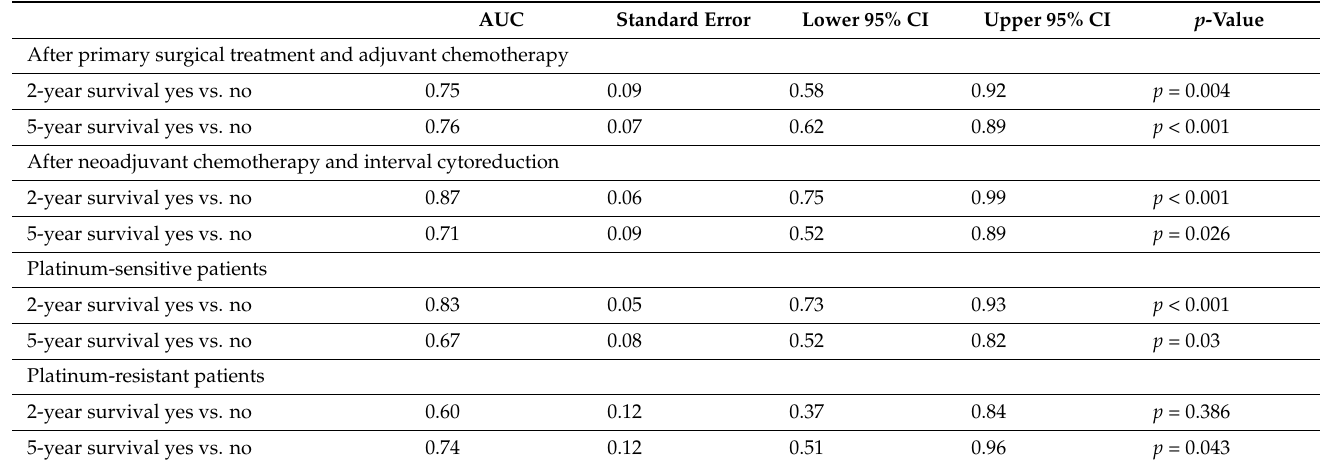
Table A3. Assessment of serum HE4 prognostic value after the last course of second-line